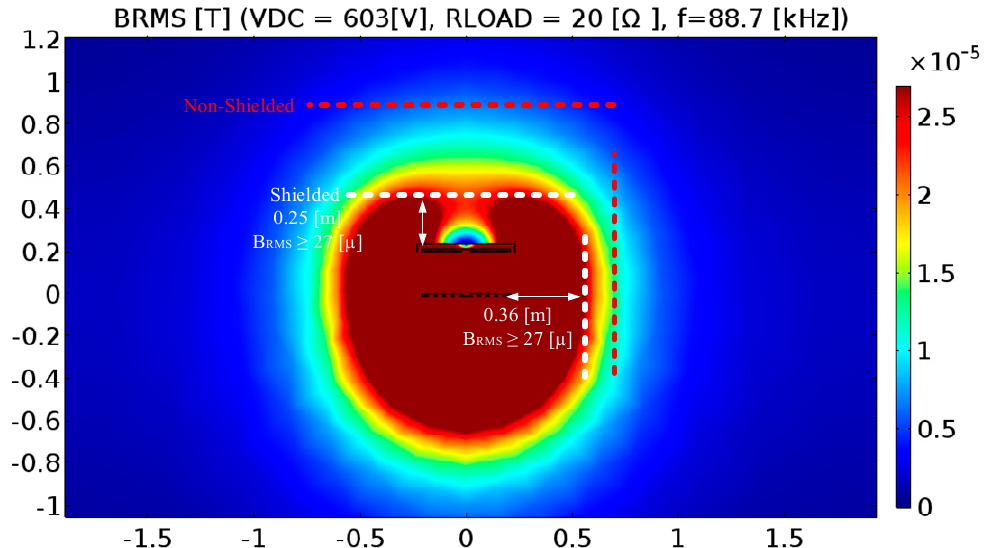
Figure 16. The distribution of the magnetic flux density of the Shielded WChS (white lines), Non-Shielded WChS (Red Lines).